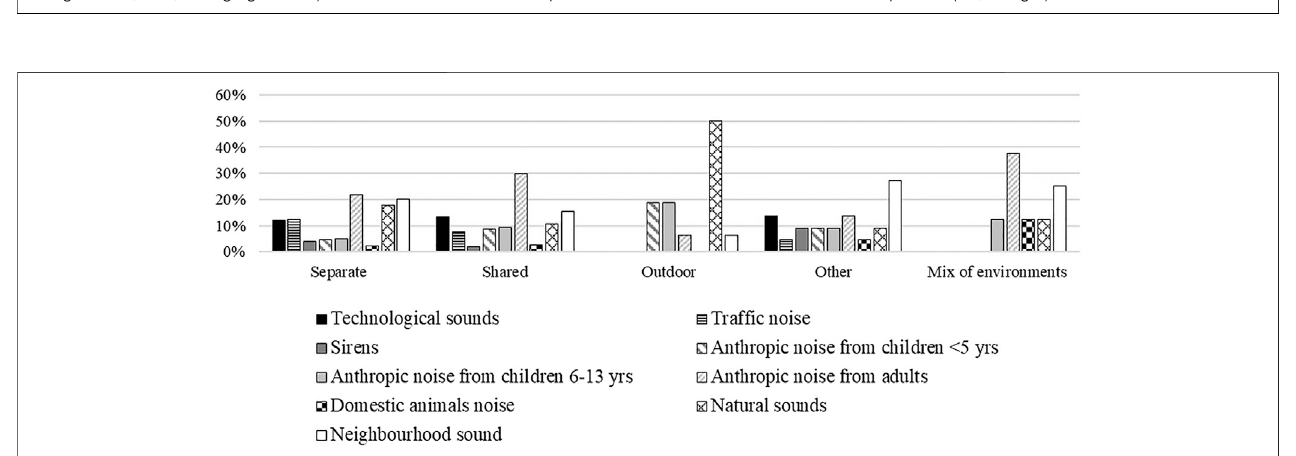
FIGURE 2 | Percentages of main sound source perceived during the remote working hours across all 1,934 respondents, divided per environment where the remote working activity takes place.